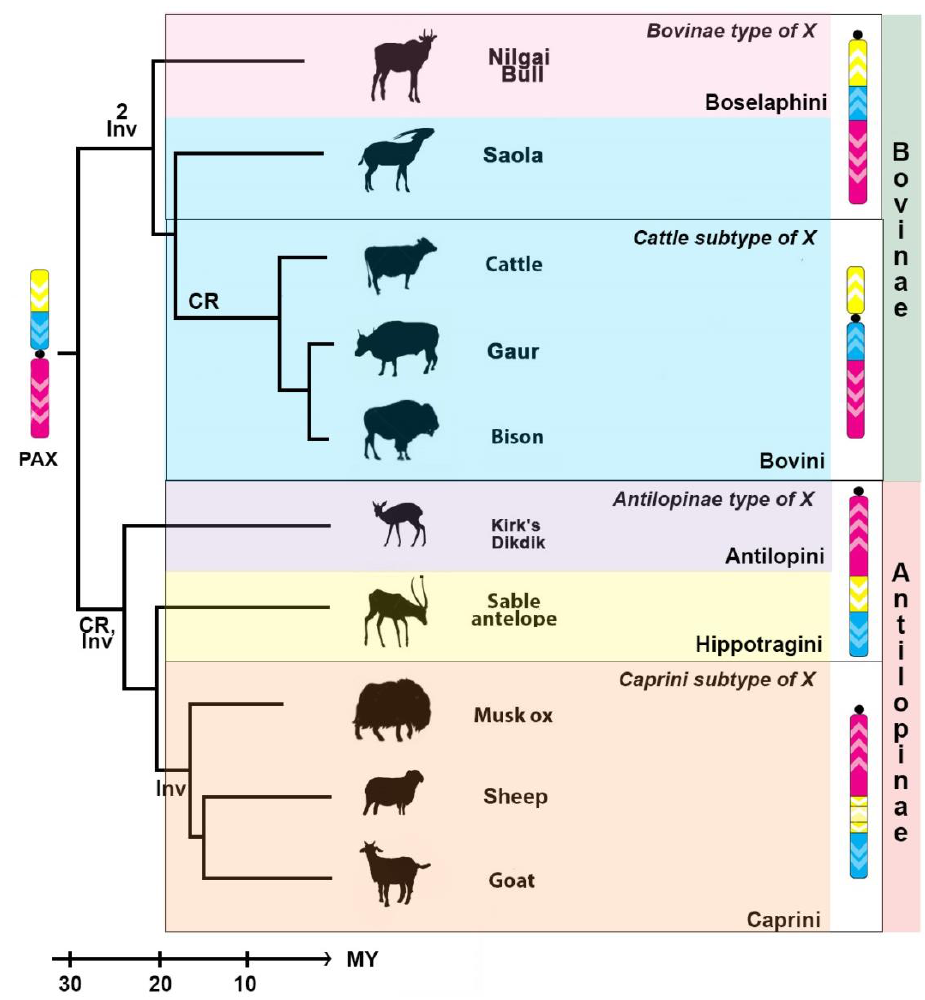
Figure 6. Changes in the structure of the Bovidae X chromosome are depicted on the phylogenetic tree of the family (the tree topology is from [40]). PAX is Pecoran ancestral X chromosome [15]. Major conservative segments are shown in yellow, blue, and pink. Centromere positions are designated by a black circle. White arrowheads show the orientation of the conservative segments. Chromosome changes are shown on phylogenetic tree near respective branches: CR—centromere reposition; and Inv—inversion. Frames show types and subtypes of the bovid X chromosome. The timescale is in million years (MY) of evolution. Nilgai bull X chromosome is shown without autosomal translocation.